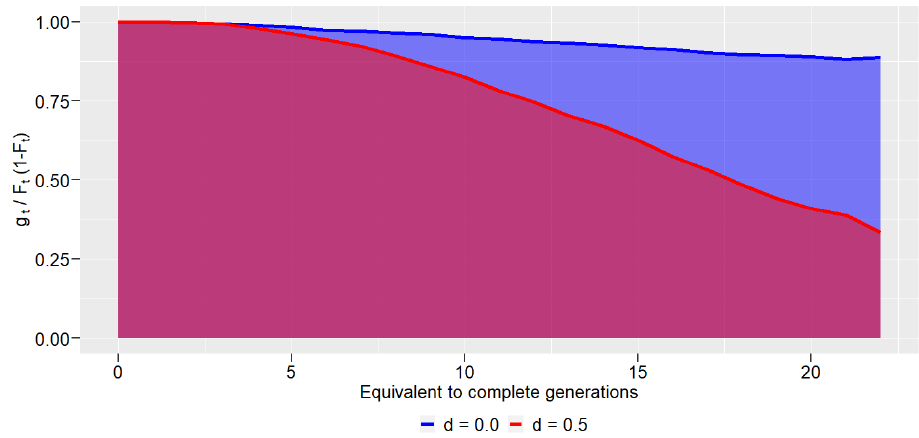
Figure 4. The proportional reduction of the inbreeding load based on García-Dorado [27].